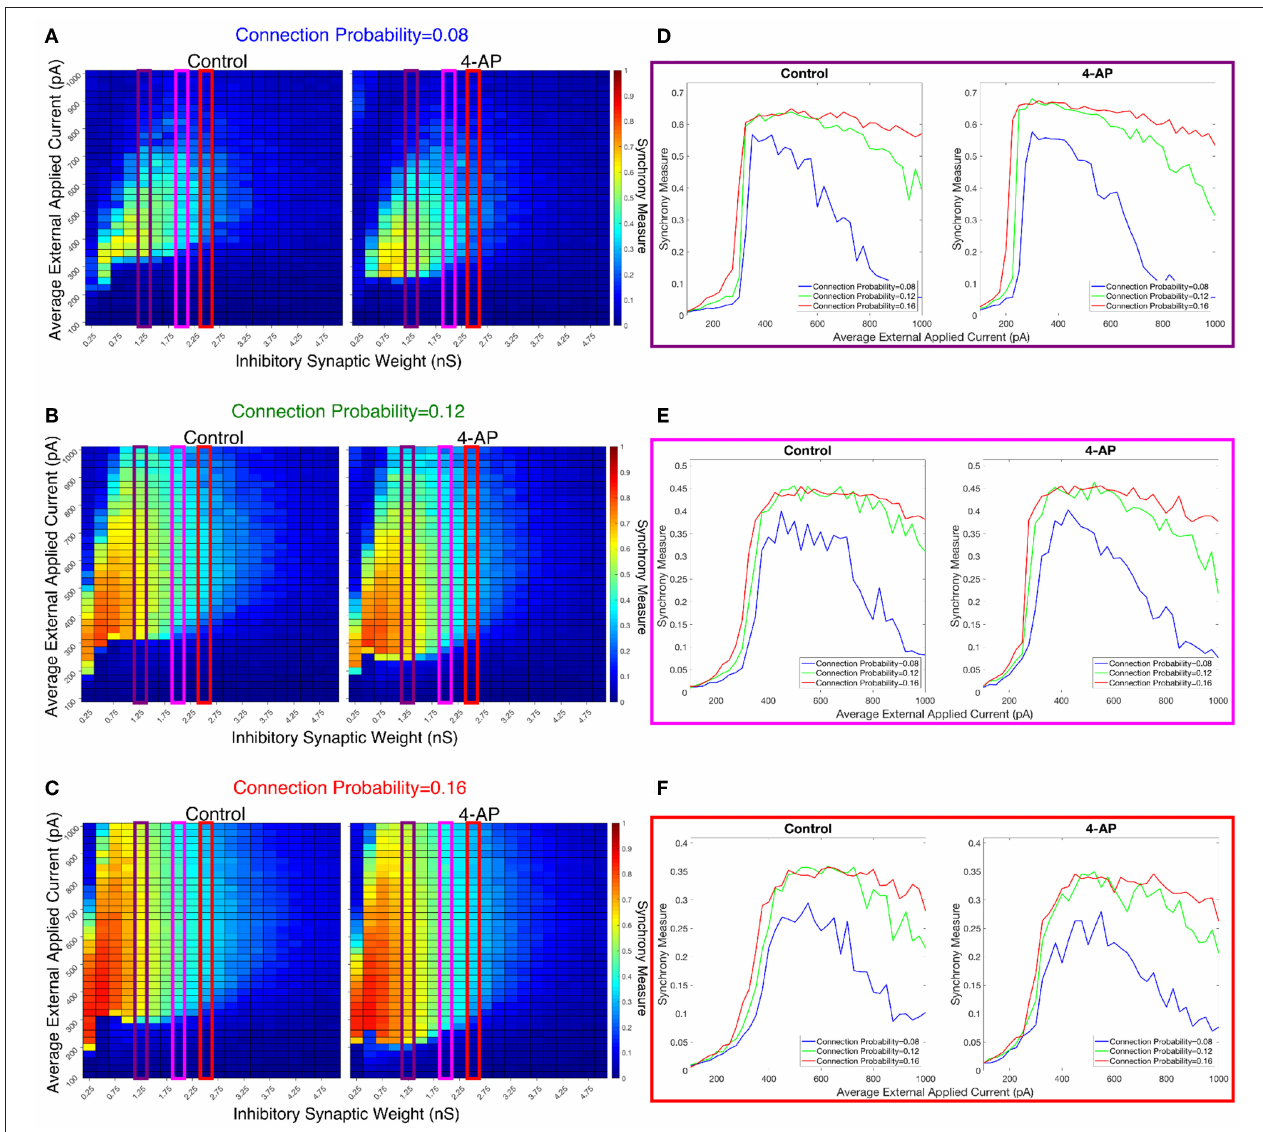
FIGURE 8 | Cortically motivated inhibitory networks exhibit a “sharp transition” between asynchronous and synchronous dynamics driven by an increase in the external drive for various connection probabilities. (A–C) Heatmaps displaying the Synchrony Measure for control networks (left) and 4-AP networks (right) with a standard deviation amongst the driving currents of 6 pA and varying connectivity densities. In these heatmaps, the inhibitory synaptic weight is varied along the x-axis and the average external applied current is varied along the y-axis, and the measure is taken from random initial conditions. (D–F) Two dimensional “slices” of the heatmaps in (A–C) taken to better illustrate the sharpness of the transition between asynchronous and synchronous dynamics as well as more easily compare this sharpness both across varying connection probabilities and between control and 4-AP conditions. (D) Shows results for an inhibitory synaptic weight of 1.25 nS, (E) for an inhibitory synaptic weight of 2.0 nS, and (F) for an inhibitory synaptic weight of 2.5 nS. There is no major difference in the tendency for 4-AP vs. control networks to exhibit the “sharp transition” from asynchrony to synchrony despite differences in the parameter regime supporting synchrony. Furthermore, the differences in the “sharpness” of the transition in the two cases are not